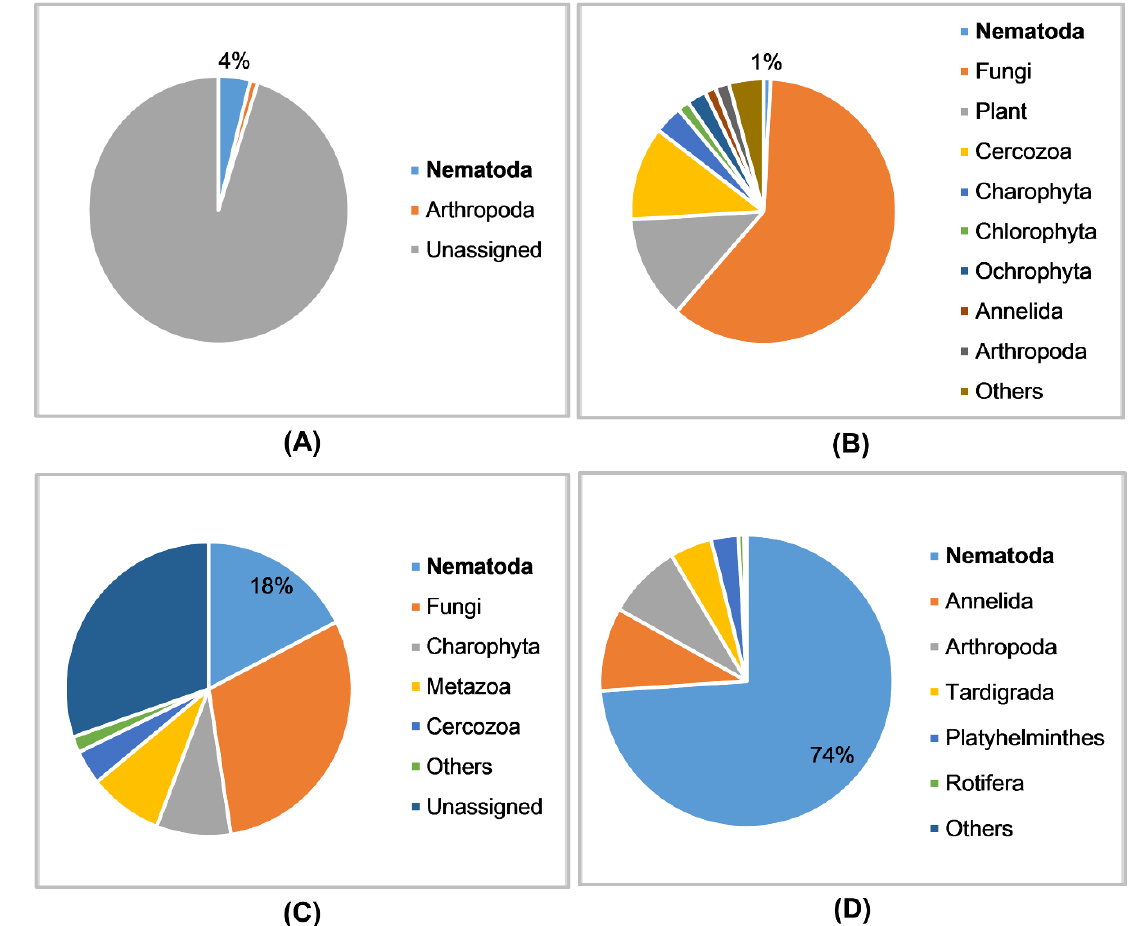
Figure 1. Relative distribution of sequence reads in soil samples amplified with JB: JB3 / JB5 ( A ), SSU: SSU_04F / SSU_22R ( B ), MMS: MMSF / MMSR ( C ), and NEM: Nemf / 18Sr2b ( D ) primer sets; percentage indicates the proportion of sequence reads that were assigned to Nematoda.